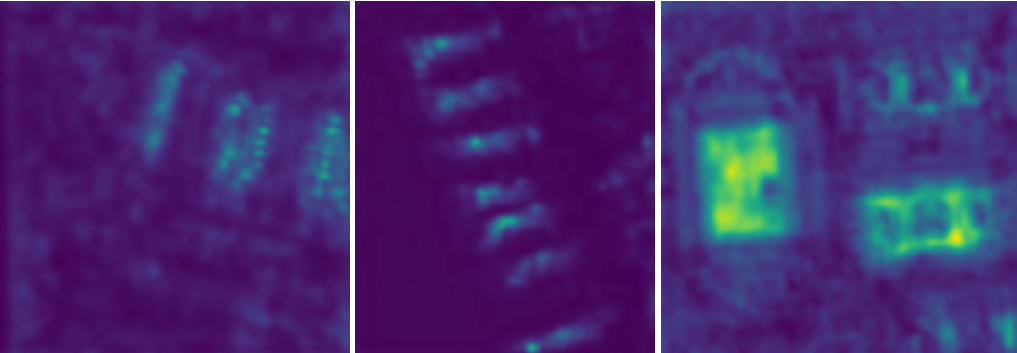
Figure 3. An example of query-independent attention map. Top row is the remote sensing images, and bottom row is the corresponding attention